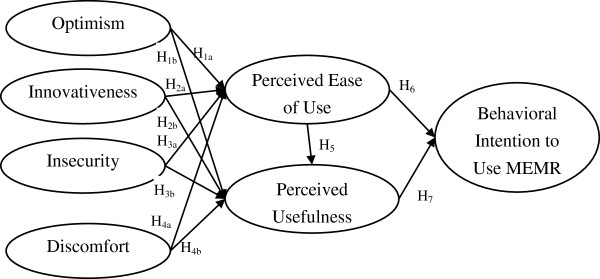
Research framework.